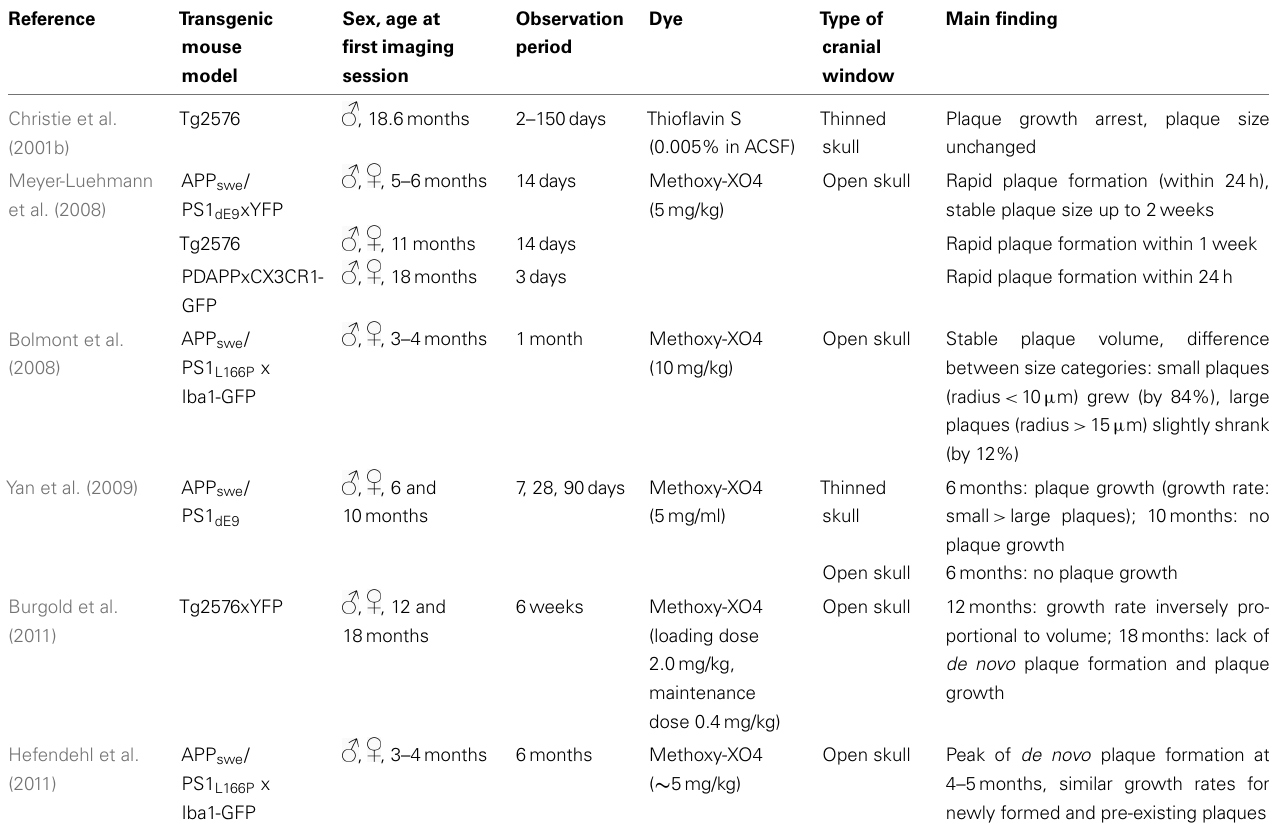
Table 2 | Studies analyzing amyloid plaque formation and growth in vivo .